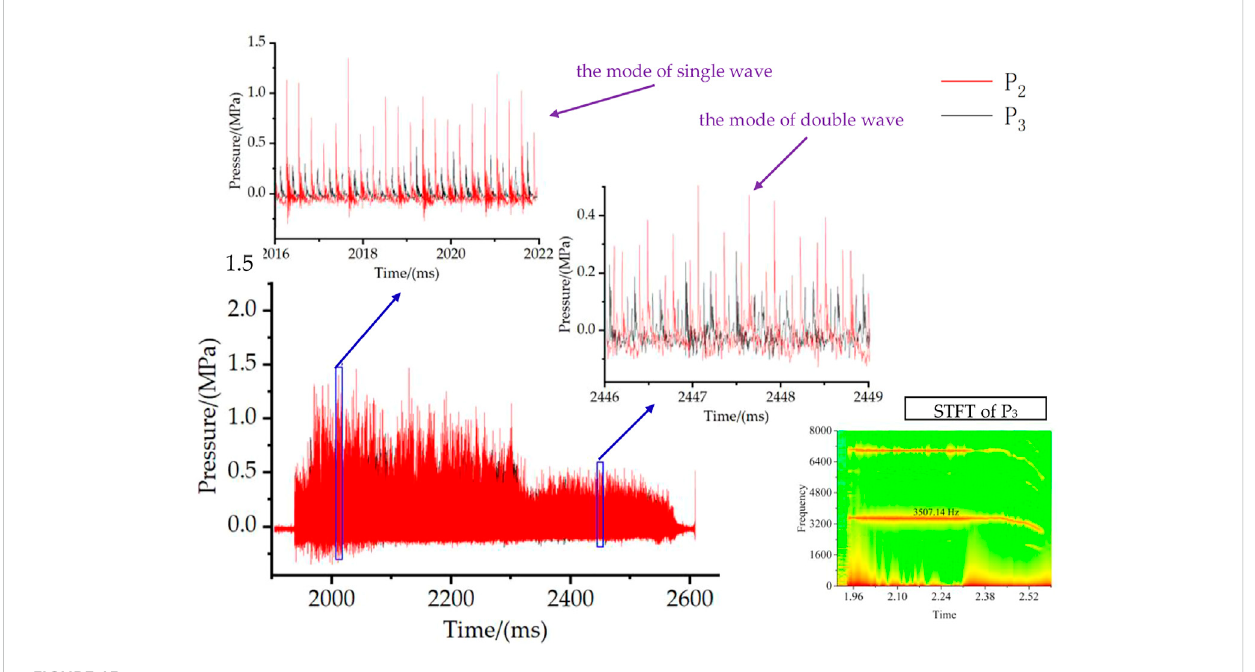
FIGURE 15 Results of operating at ER = 1.2, l w = 4 mm, and l c = 80